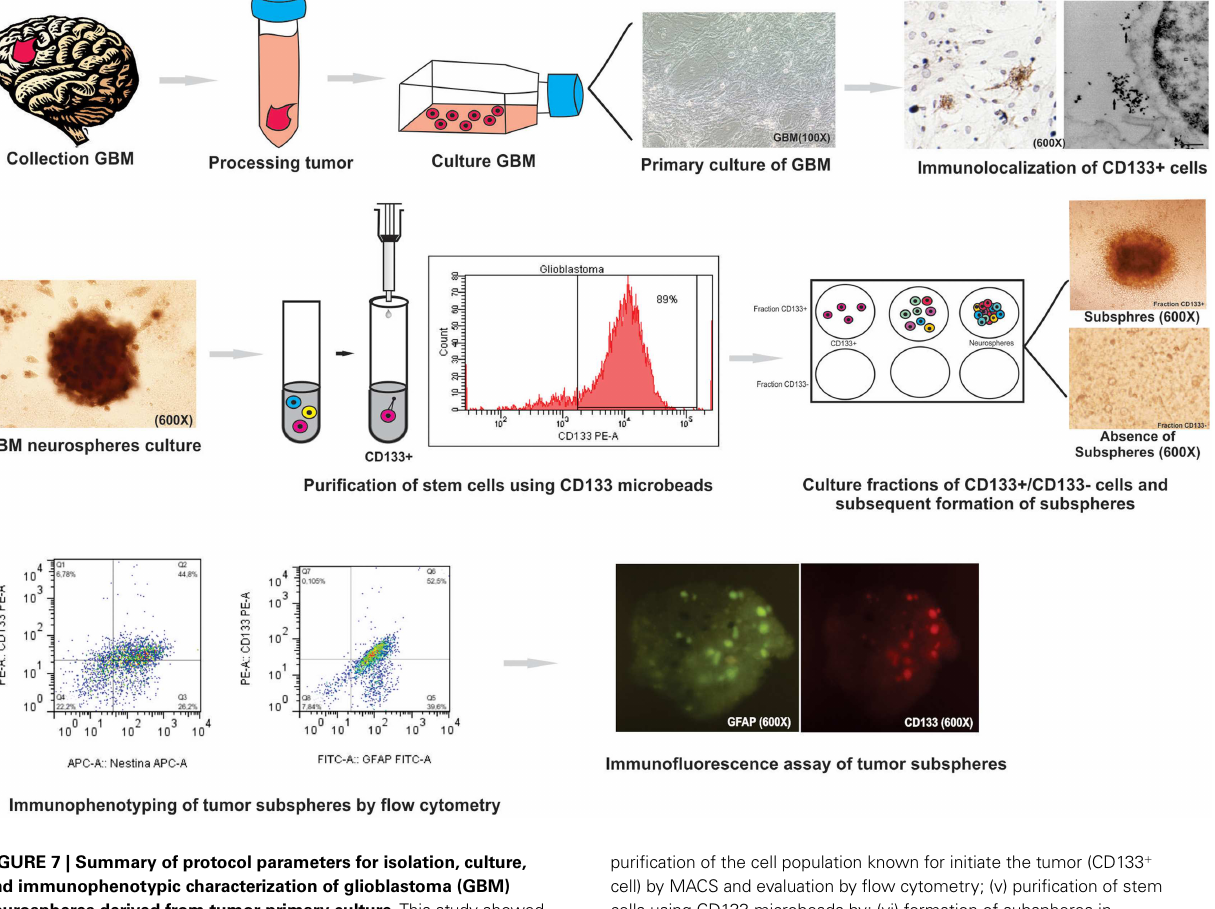
FIGURE 7 | Summary of protocol parameters for isolation, culture, and immunophenotypic characterization of glioblastoma (GBM) neurospheres derived from tumor primary culture .This study showed that the method is effective for: (i) the establishment of primary glioblastoma cell culture; (ii) study immunocytochemical and ultrastructural staining of CD133 cells glioblastoma: (iii) culture and isolation of tumor neurospheres derived of primary culture; (iv)